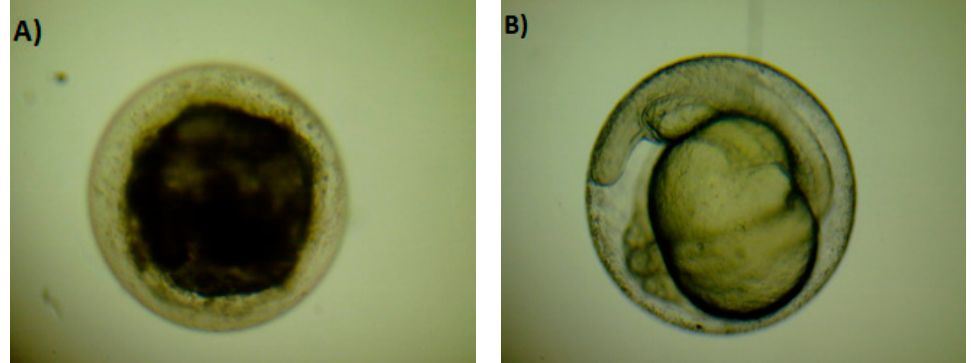
Figure 1. Coagulation of embryo exposed to 10 µ g/L of PBSA after 48 h post fertilization (hpf) ( A ). Physiological development of embryo in the control group at 48 hpf ( B ).